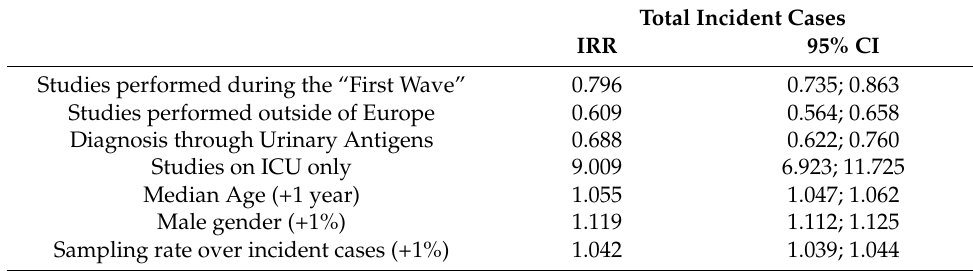
Figure 3. Border-enhanced funnel plot for studies included in the meta-analysis ( a ), and the corre- sponding radial plot ( b ). Visual inspection of the contour-enhanced funnel plot suggested substantial evidence of publication bias, and this was substantially excluded by the Egger test (i.e., t = − 1.25, df = 25, p -value = 0.2235). In fact, in radial plots, the studies on were substantially scattered across the regression line, suggesting no significant small study effect. Table 3. Incidence rate ratios (IRR) for Legionnaires’ Disease (LD) cases among SARS-CoV-2 diagnoses by settings of the diagnoses. IRR were calculated by means of a Poisson logistic regression, the incident cases of LD assuming as outcome variables. Note: 95% CI = 95% Confidence Intervals; ICU = intensive care unit; PCR = polymerase chain